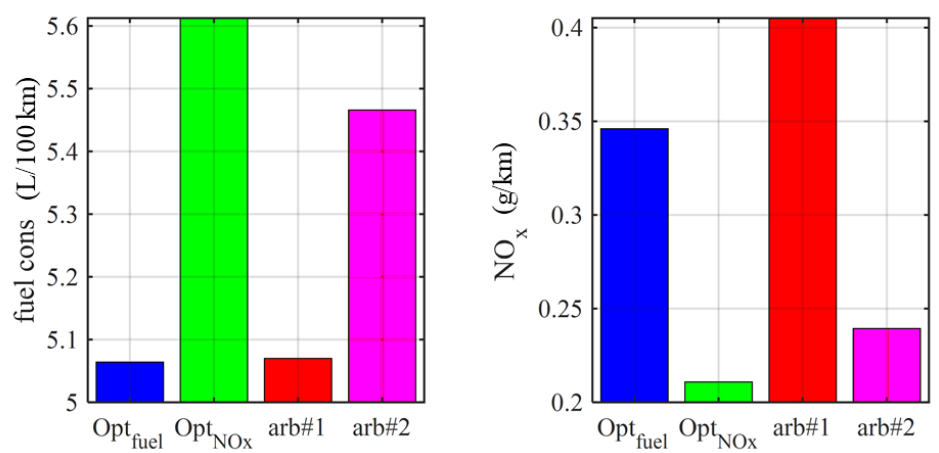
Figure 9. Total fuel consumption ( left ) and NO x emission ( right ) values resulting from the exper- imental driving cycles: optimal speed for minimum fuel consumption (blue), optimal speed for minimum NOx emissions (red) and two arbitrary driving cycles (red and magenta).